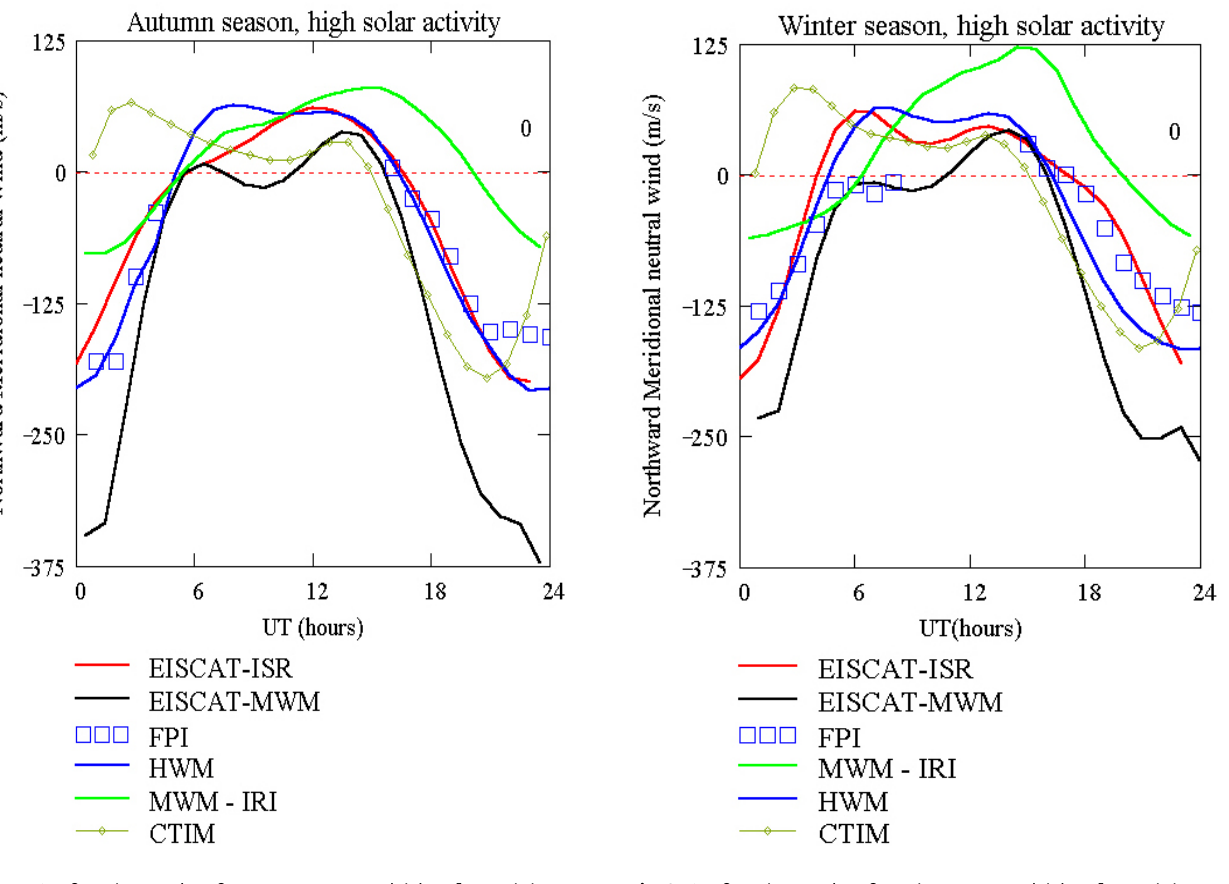
Fig. 8. As for Figure 1 but for winter season, high solar activity.